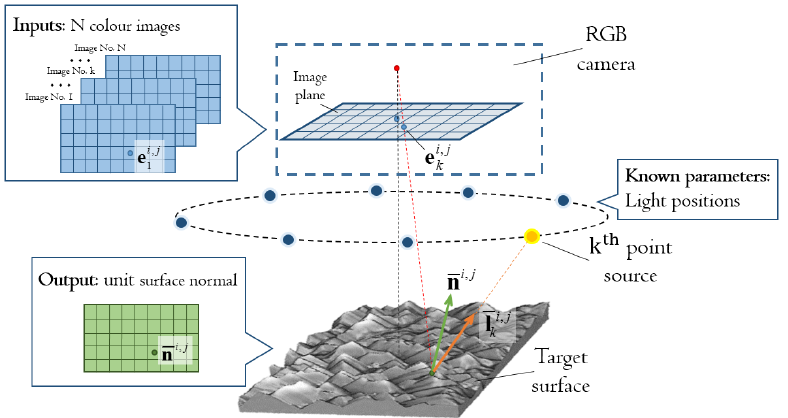
Figure 1. Schematic diagram for generic colour